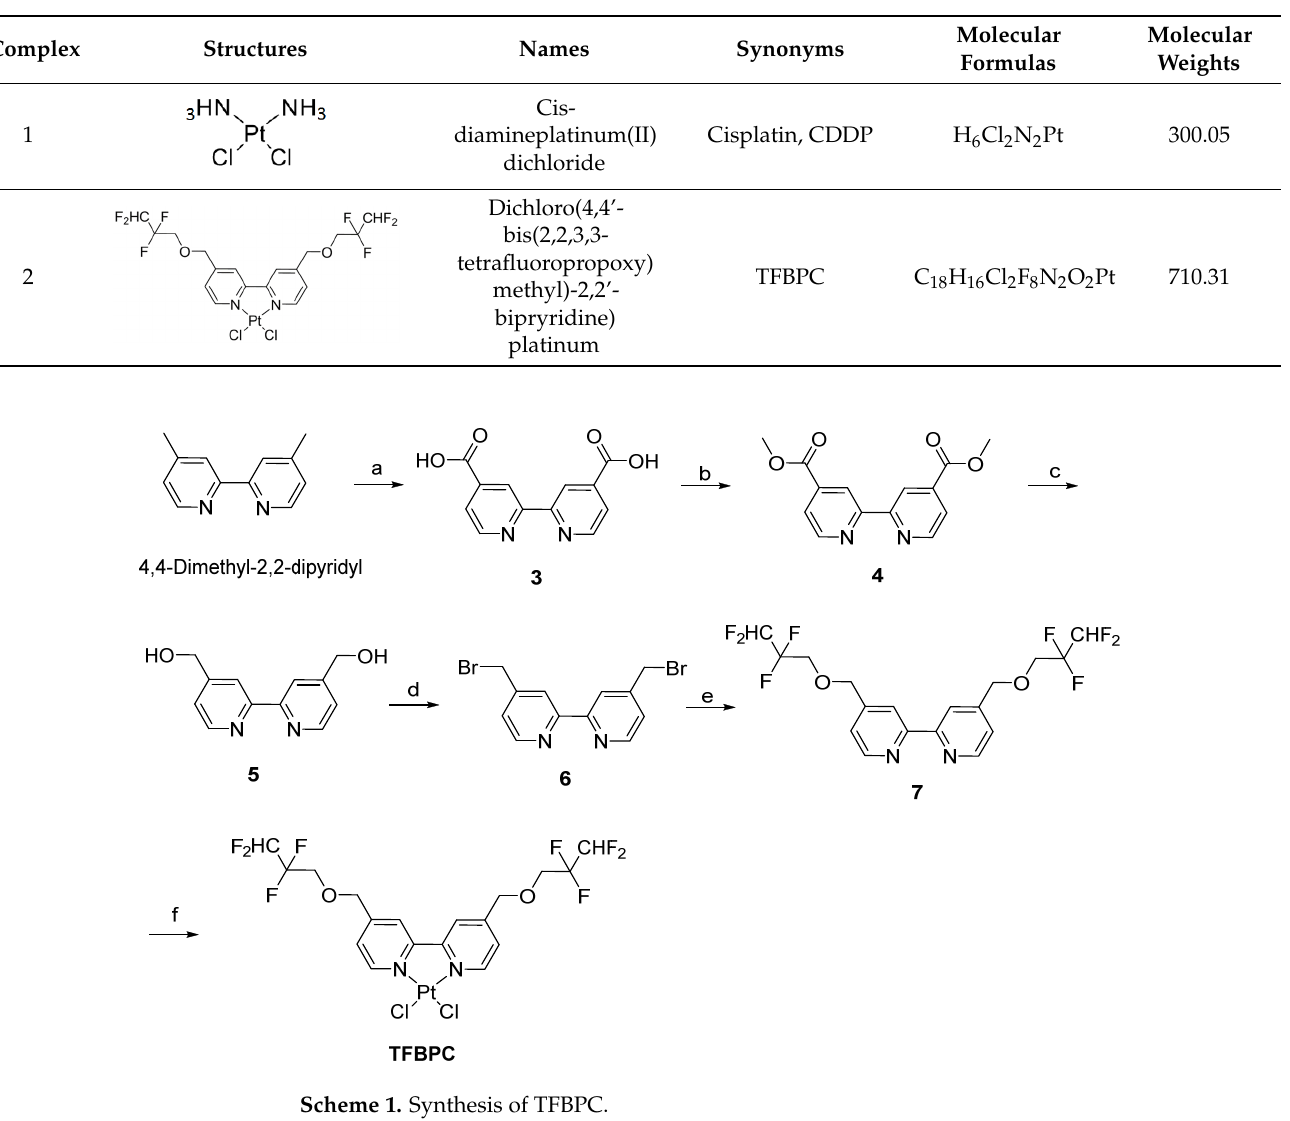
Table 1. Chemical structures and properties of platinum-based